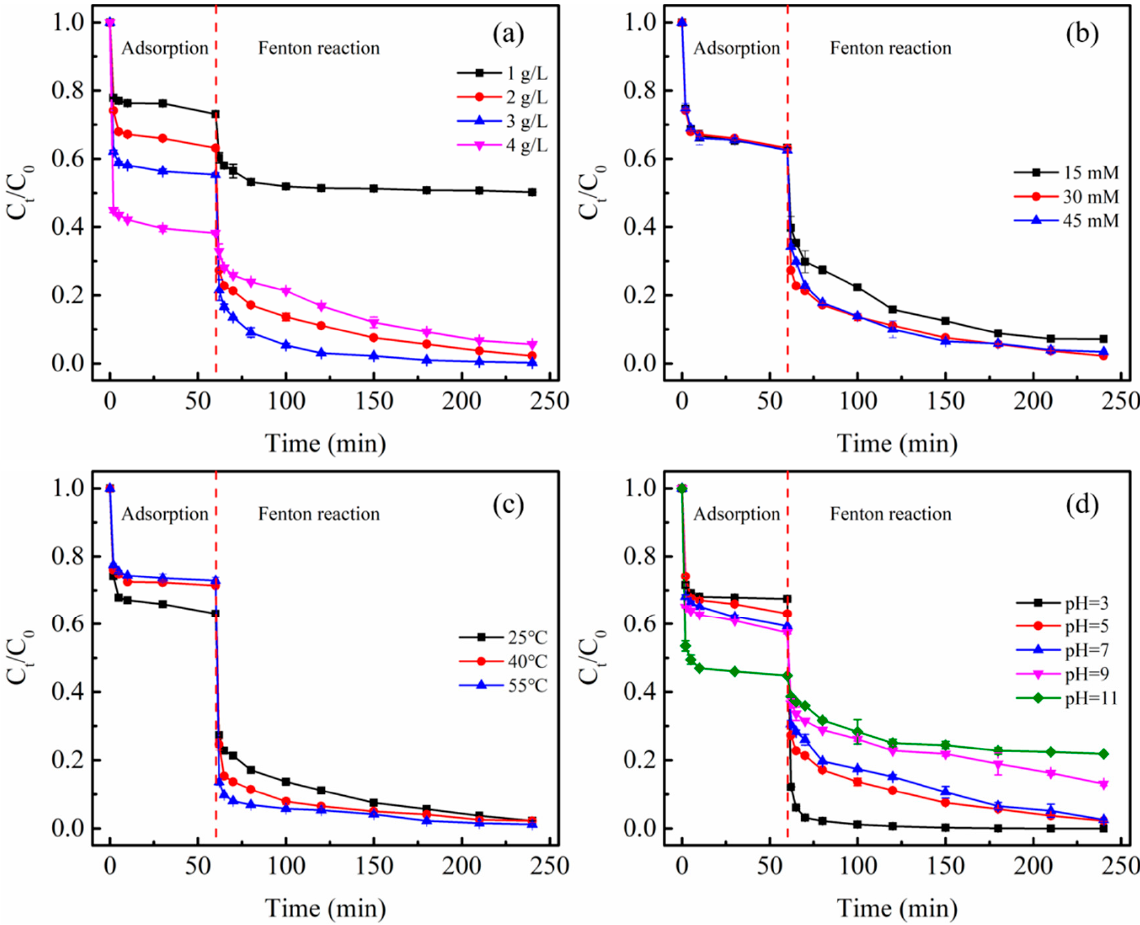
Figure 6. ( a ) Adsorbent dosage, ( b ) H 2 O 2 concentration, ( c ) temperature, and ( d ) initial pH affections on the decolorization efficiency of MB. Except for the studied parameters, other parameters were fixed at pH = 5.0, Fe 3 O 4 @C = 2.0 g/L, [H 2 O 2 ] = 30 mM, [MB] = 100 mg/L, and temperature 25 °C.